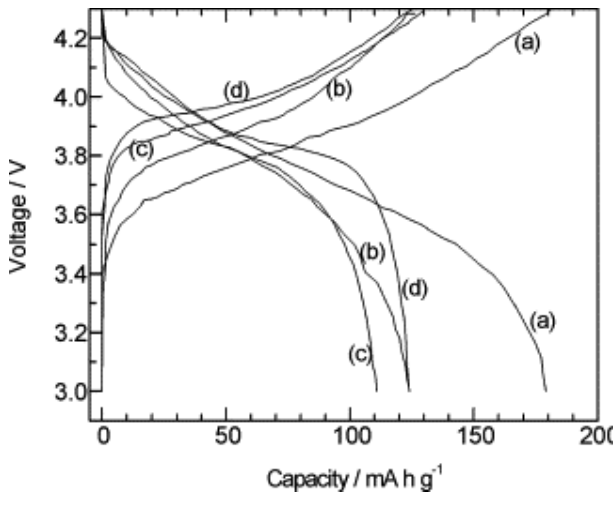
Figure 3. Charge and discharge curves of Li/PEO/LTAP/LiCoO annealing temperatures: ( a ) as-deposited; ( b ) 300 °C; ( c ) 400 °C and ( d ) 500 °C